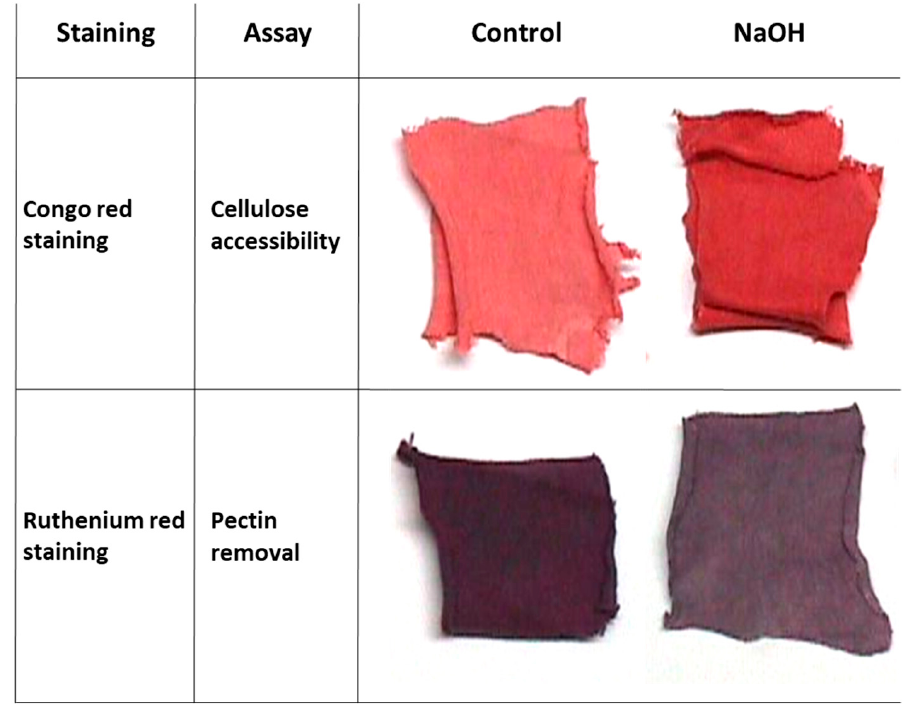
Figure 1. Influence of NaOH treatment on the removal of cotton fibers’ outer layer non-cellulosic substances, including waxes and pectin. The traditional chemical treatment outcome is evidenced by a concomitant increase in color upon staining with Congo red and decreased color upon staining with Ruthenium red. The chemical treatment was done by incubating the fabrics in 100 °C boiling 250 mM NaOH solution for 30 min.